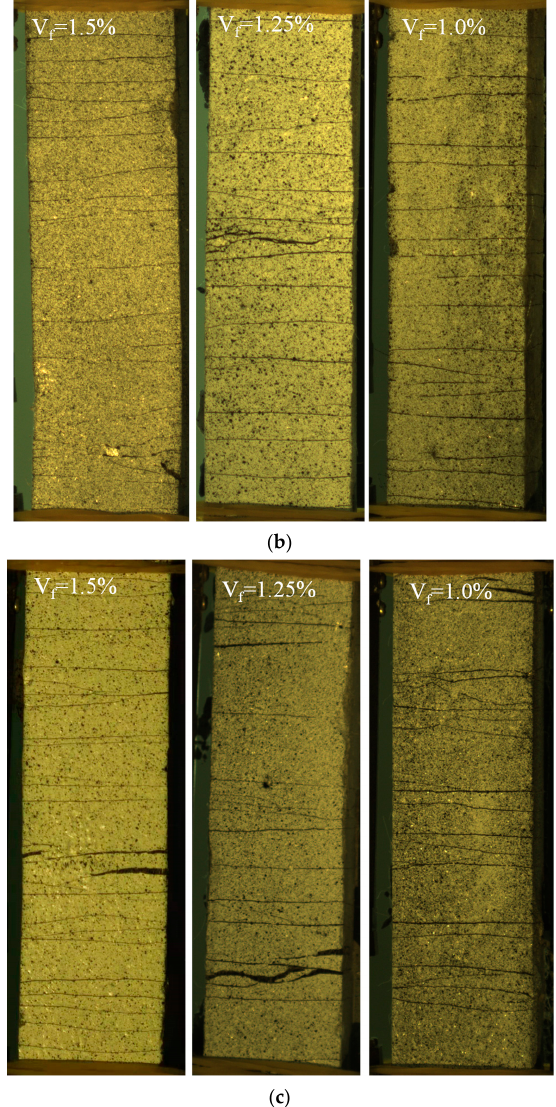
Figure 16. Cracking pattern of GLECC mixtures. ( a ) GLECCs with FAC content of 0.15; ( b ) GLECCs with FAC content of 0.3; ( c ) GLECCs with FAC content of